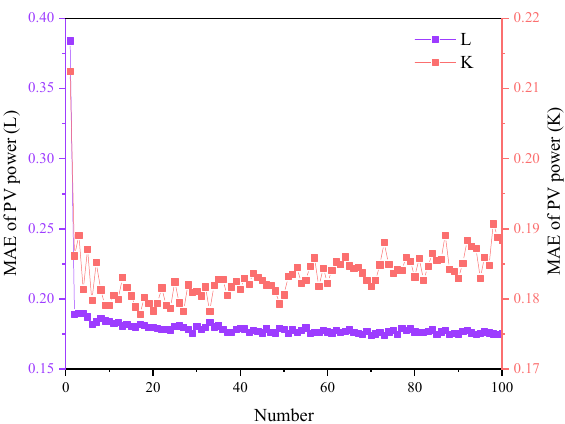
Figure 13. MAE of PV power prediction with different values of hyperparameters.